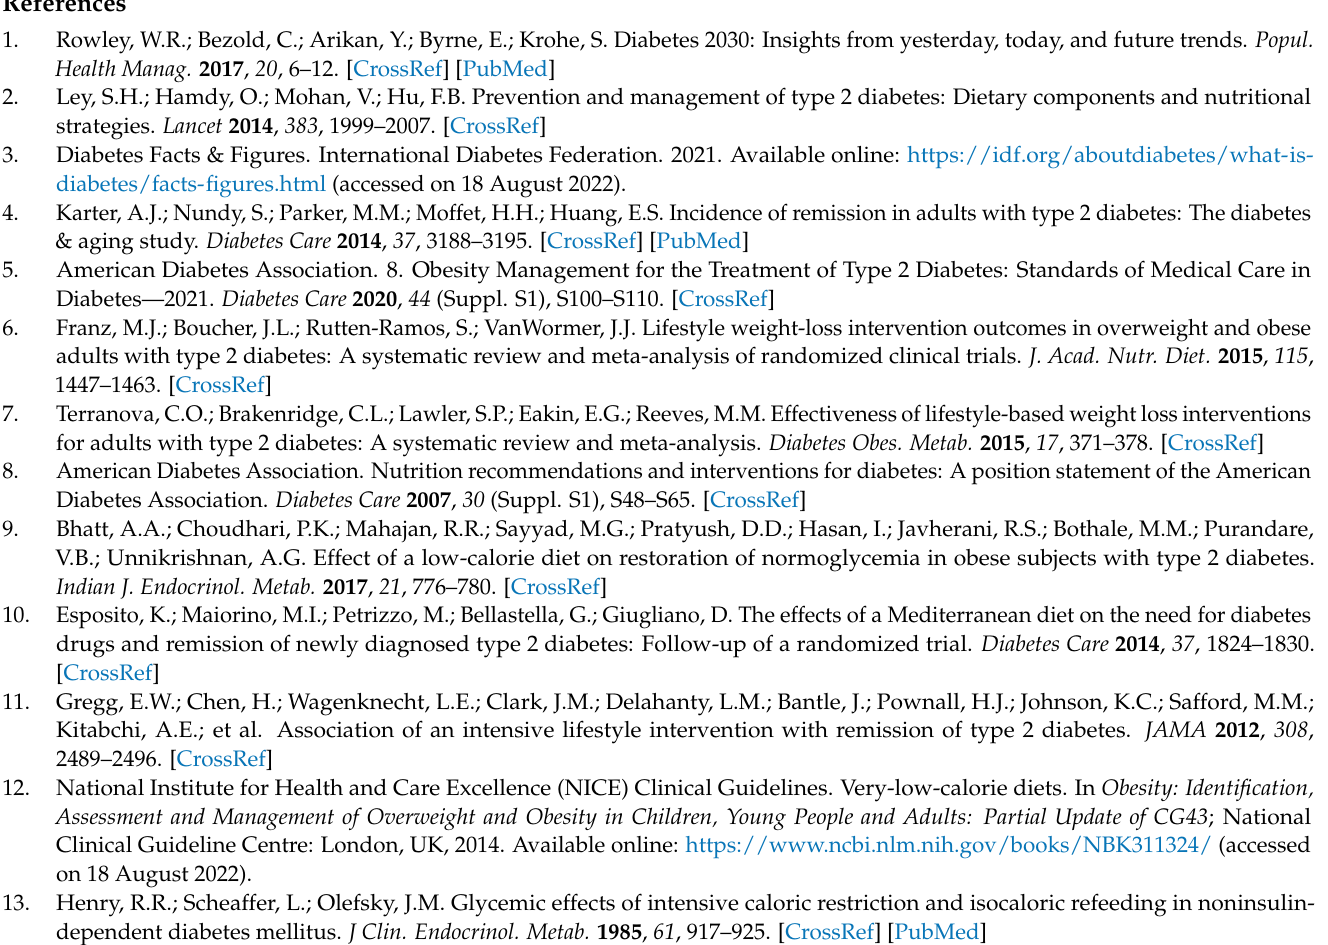
diets, Figure S4: Forest plot comparing the reduction in total cholesterol after consumption of low-fat vegan and control diets, Figure S5: Forest plot showing mean HDL cholesterol after consumption of low-fat vegan and control diets, Figure S6: Forest plot comparing the reduction in triglycerides after VLCD diets and non-dietary therapies, Figure S7: Forest plot comparing the reduction in total cholesterol after VLCD diets and non-dietary therapies, Figure S8: Forest plot showing mean fasting insulin levels after VLCD and non-dietary therapies, Figure S9: Forest plot showing mean HDL cholesterol VLCD and non-dietary therapies; Table S1: Study Characteristics of Included